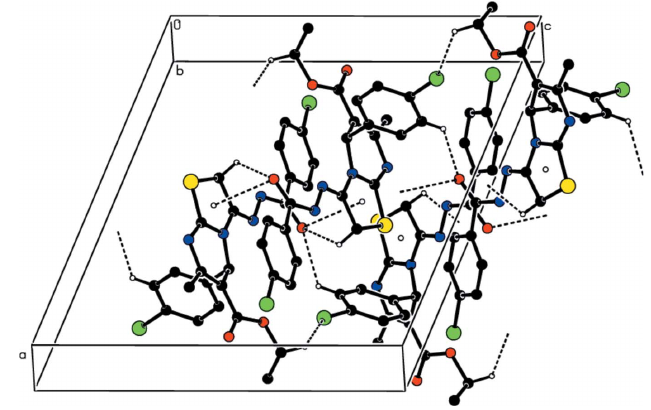
Figure 3 Detail of the C—H (cid:2)(cid:2)(cid:2) O and C—H (cid:2)(cid:2)(cid:2) Cl hydrogen bonds and the (cid:2) - interactions down the b -axis. H atoms not involved in these interactions have been omitted for clarity.